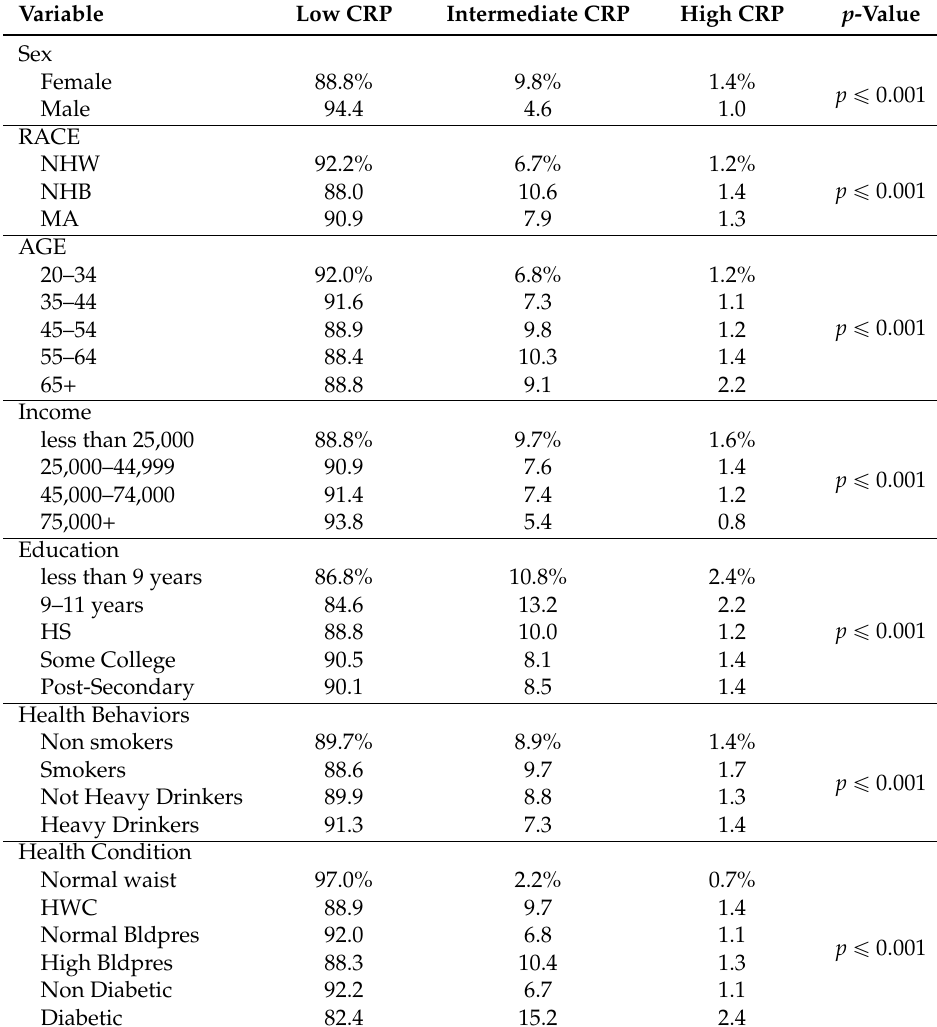
Table 2. Weighted descriptive statistics by C-reactive protein